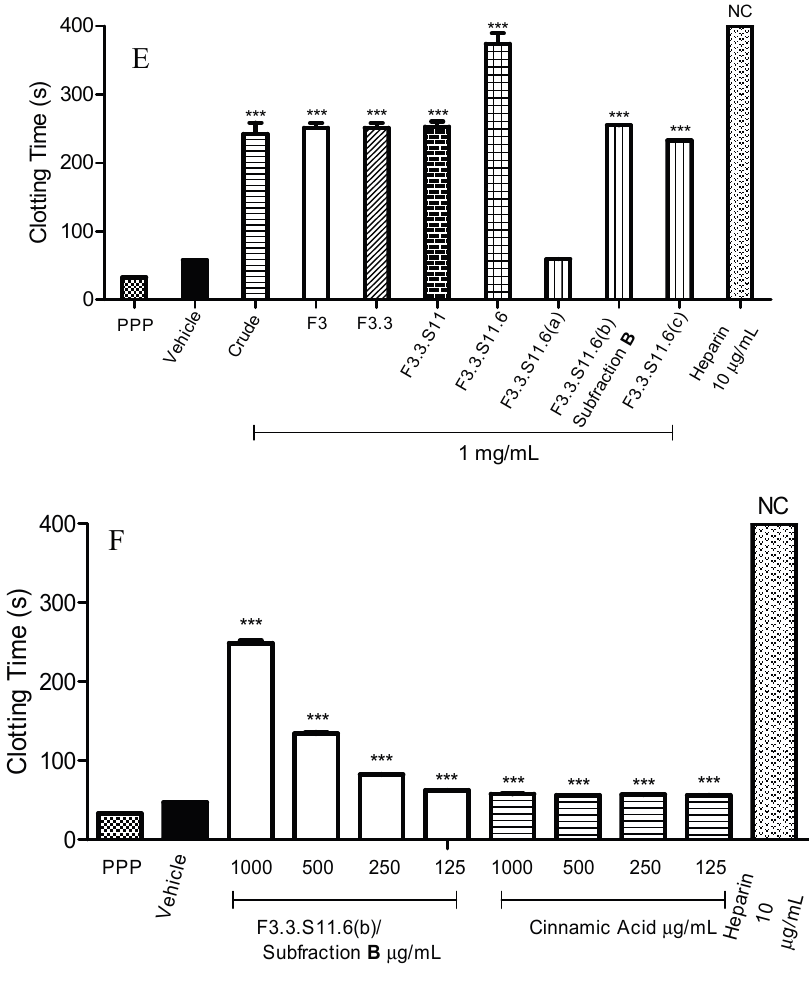
Figure 1. Activated partial thromboplastin time (APTT) of fractions obtained through bioassay guided fractionation. ( A ) APTT of fractions F3.1 to F3.6; ( B ) APTT of Subfraction A ; ( C ) APTT of fractions F3.3.S11 to F3.3.S21; ( D ) APTT of fractions F3.3.S11.1 to F3.3.S11.10; ( E ) APTT of fractions F3.3.S11.6(a) to F3.3.S11.6(c); ( F ) APTT of